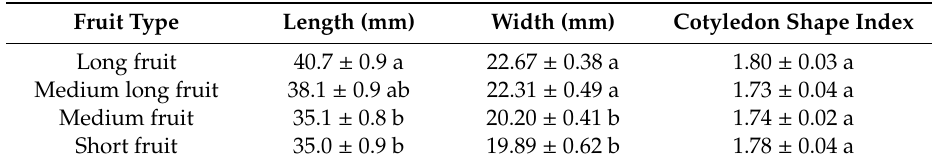
Table 3. Cotyledon shape traits of four types of bar